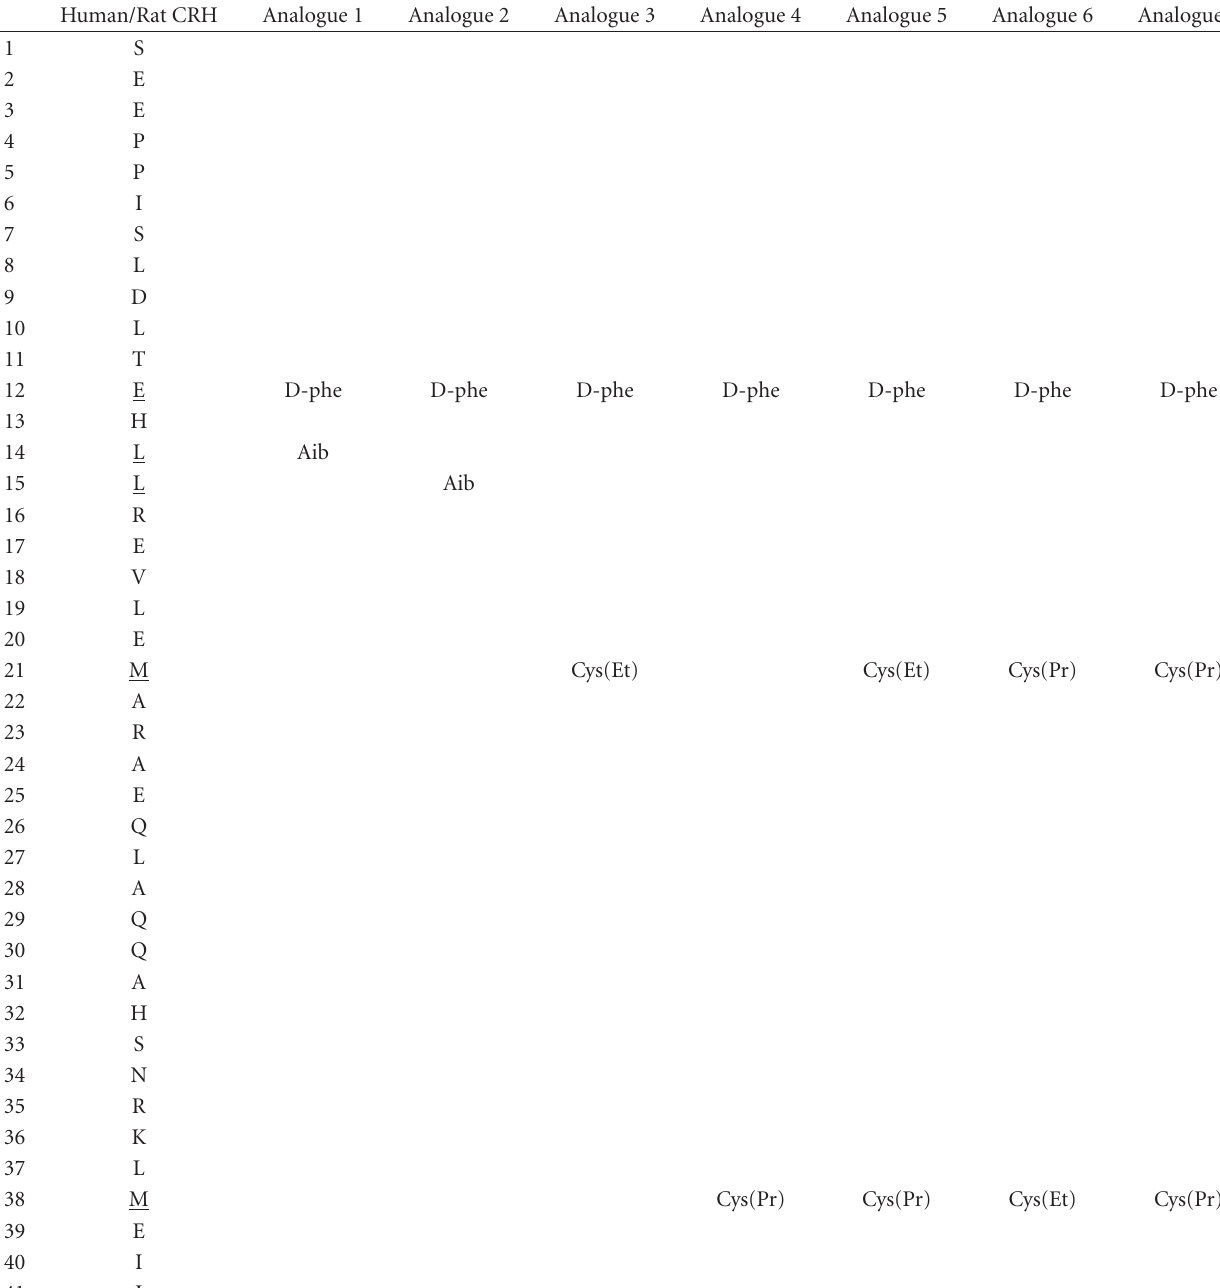
Table 1: Structure of synthesized CRH